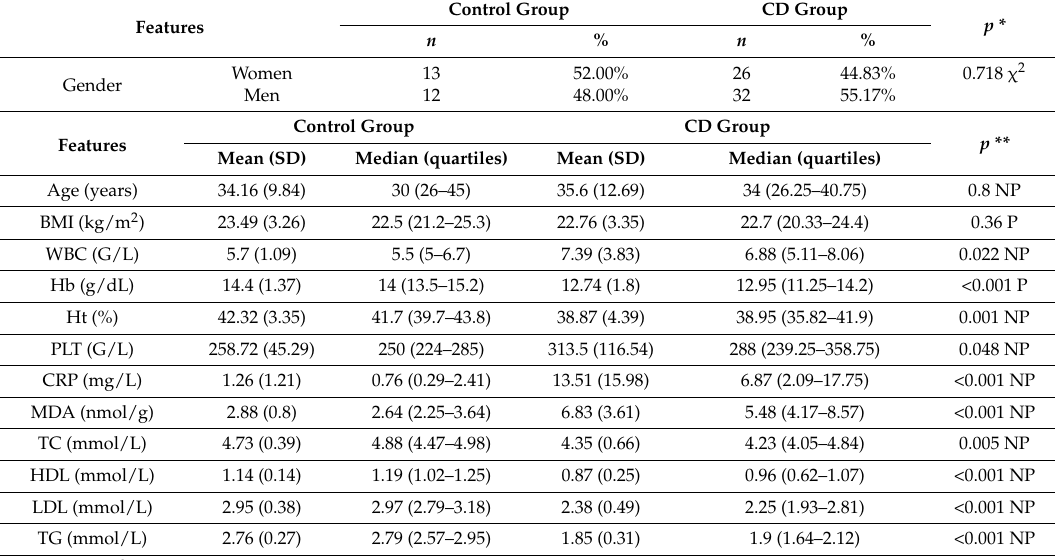
Table 1. The characteristics of group of patients with Crohn’s disease (CD) and control volunteers. A p value < 0.05 demonstrate significant differences between the two groups.